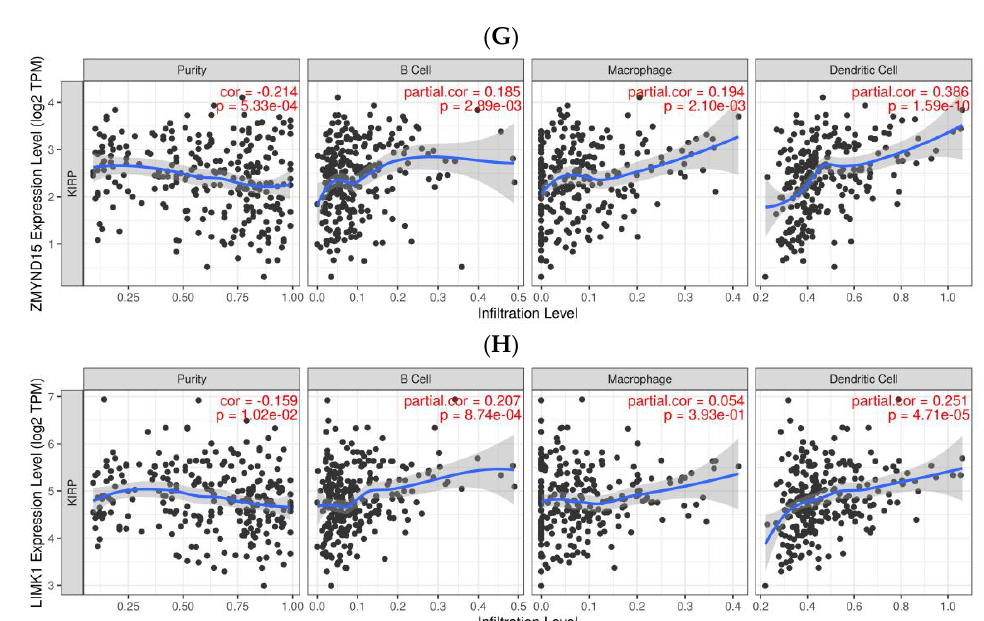
Figure 3. The associations between five potential PRCC antigens and three types of APCs. ( A ) The number of separate and common genes among mutated, upregulated and survival-related groups. ( B ) Pie chart from Funrich [32] revealing the major biological processes these common genes participate in. ( C )The expression associations between intersected genes and APCs based on the ssGSEA method. ( D – H ) The expression correlations between ALOX15B ( D ), HS3ST2 ( E ), PIGR ( F ), ZMYND15 ( G ), LIMK1 ( H ) and infiltration degrees of APCs were quantified with the TIMER database.